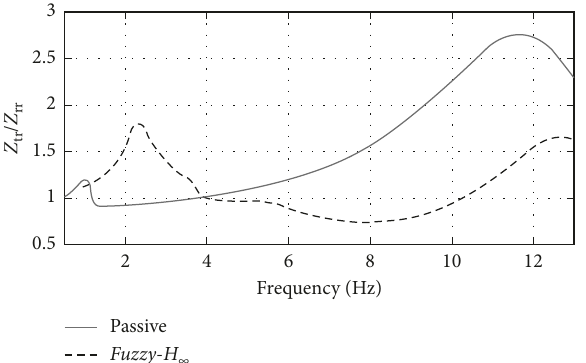
Figure 20: Relation (cm) between front tire displacement and road profile.